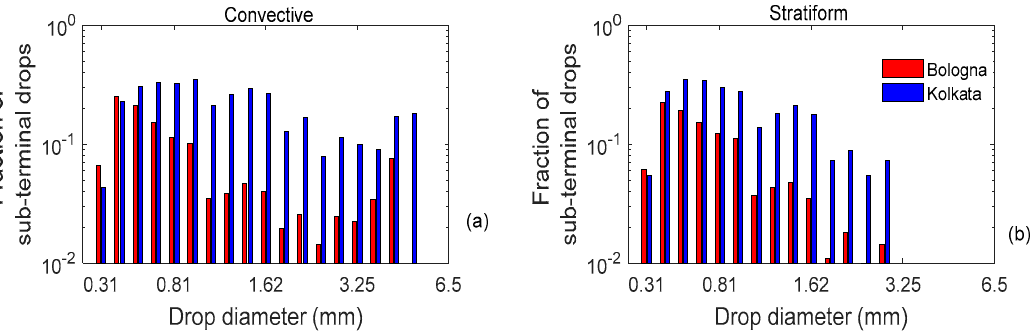
Figure 6. Fraction of sub-terminal drops for ( a ) convective and ( b ) stratiform rain in Kolkata and Bologna. The fraction of sub-terminal drops represents the ratio of these drops and the total number of drops.